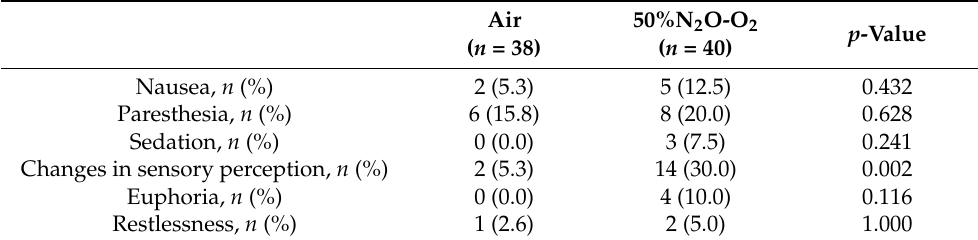
Table 3. Side effects described by the 78 patients with completed data, by randomization group. Only minor and transient side effects were reported.